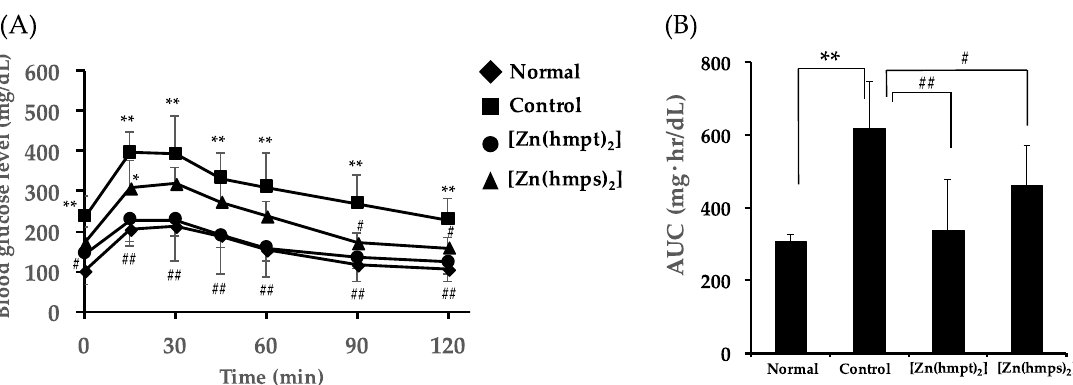
Figure 4. Oral glucose tolerance test (OGTT) after 28 days in normal, control (PEG-400 administered), [Zn(hmpt) 2 ]-treated, and [Zn(hmps) 2 ]-treated mice. ( A ) Changes in blood glucose levels after gastric gavage of 1 g glucose/kg body weight and ( B ) Area under the blood glucose concentration-time curve (AUC) in OGTT; data are expressed as the means ± SDs for 6–8 mice. Statistical analysis was performed using the Tukey–Kramer test; significance: * p < 0.05 and ** p < 0.01 vs. normal mice, # p < 0.05 and ## p < 0.01 vs. control mice.